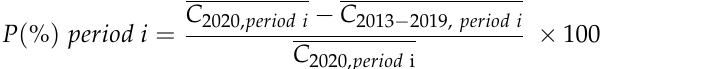
Figure 5. Trend normalisation of NO 2 concentrations from 2013 to 2019 at the Zapatón site, using the “deweather” package [10].